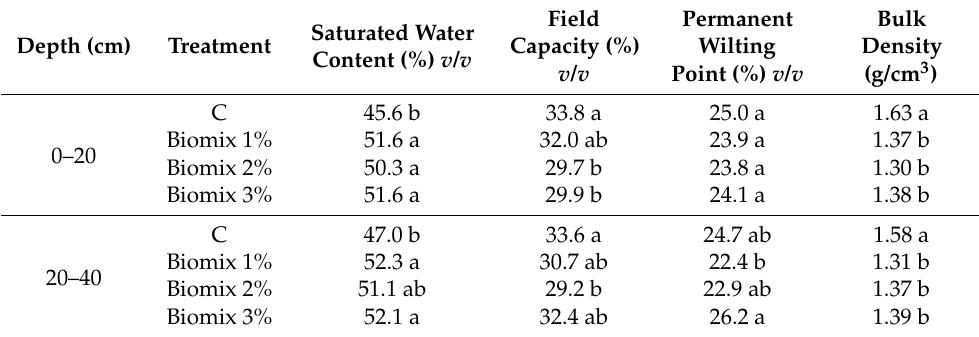
Table 3. Saturated water content, field capacity, permanent wilting point and bulk density changes in the samples of the four treatments z